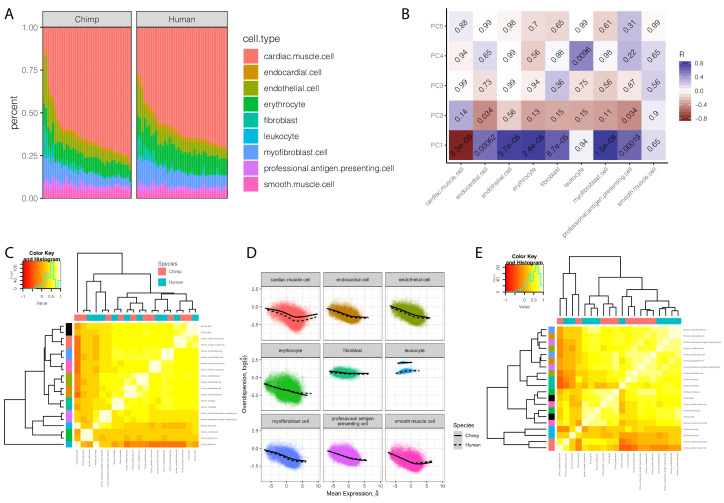
Expression and dispersion estimates that correct for cell type composition.(A) The cell type composition estimates of chimpanzee and human bulk RNA-seq samples used in dispersion. Height of colored bars represents estimates of the proportion of each heart cell type. (B) A heatmap of the Pearson correlation between the principle components of the chimpanzee samples used in eQTL mapping, to their cell composition estimates. Benjamini-Hochberg corrected P-values for the correlation shown as text in each cell. (C) Correlation matrix of cell-type-specific population mean expression estimates estimated from deconvoluted bulk data. Hierarchal clustering reveals a clear clustering of cell types (row colors, same color key as in (A), with bulk expression profiles colored as black) over species (column colors). (D) Individual cell-type expression estimates were used to estimate dispersion with the same approach as used in bulk data: Cell-type-specific dispersion is defined as the residual of the depicted LOESS fit over the mean-overdispersion trend in each cell type in each species. (E) Correlation matrix of cell-type-specific dispersion estimates reveals a mixed hierarchal clustering pattern with respect to cell-type and species (rows and columns colored same as C). Full cell-type-specific expression and dispersion estimates used to create Pearson correlation matrices in (C) and (E) available as Figure 4—figure supplement 1—source data 1.Figure 4—figure supplement 1—source data 1.Cell-type-specific expression and dispersion estimates.